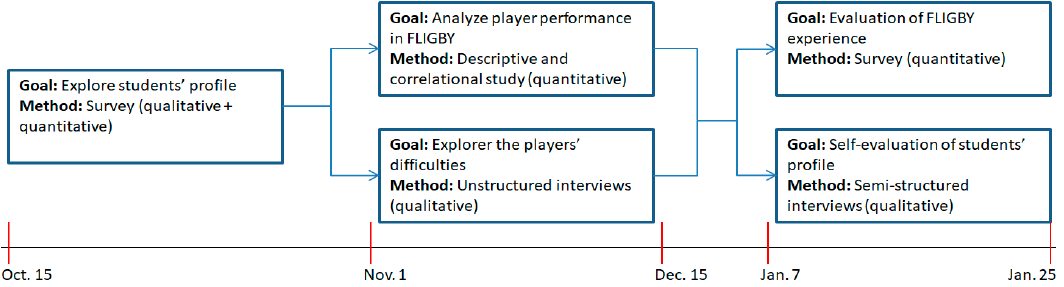
Figure 3. Phases of the adopted methodology (author’s own illustration).